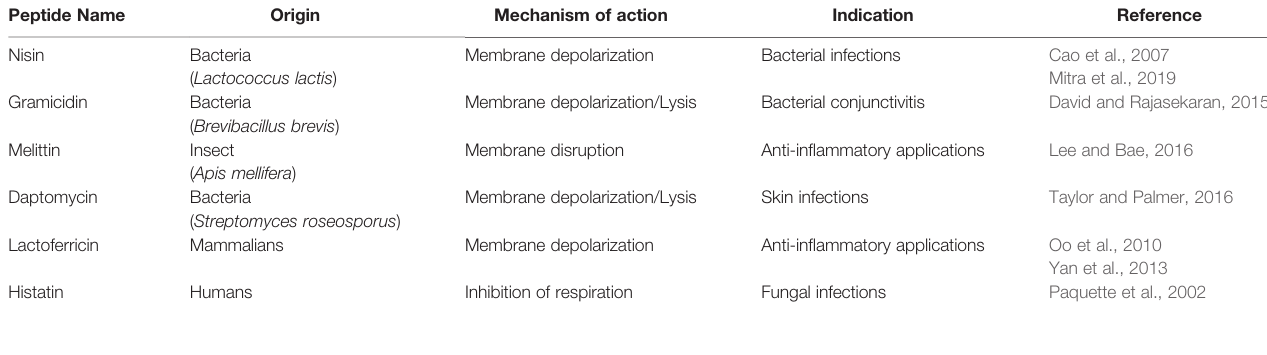
TABLE 2 | List of natural AMPs in clinical practice.